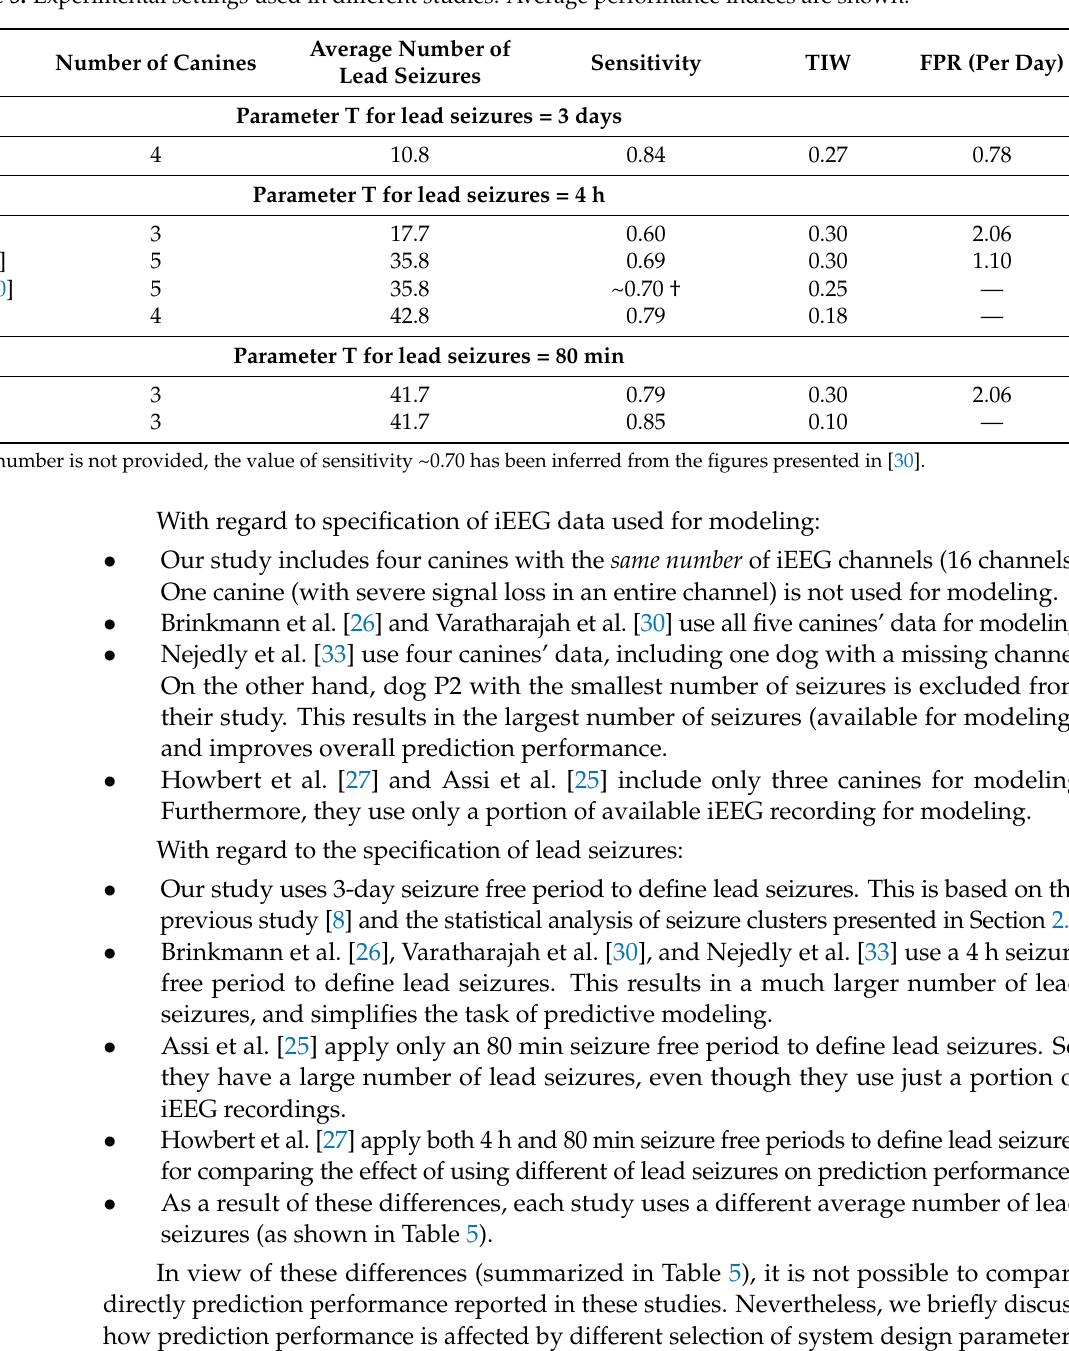
Table 5. Experimental settings used in different studies. Average performance indices are